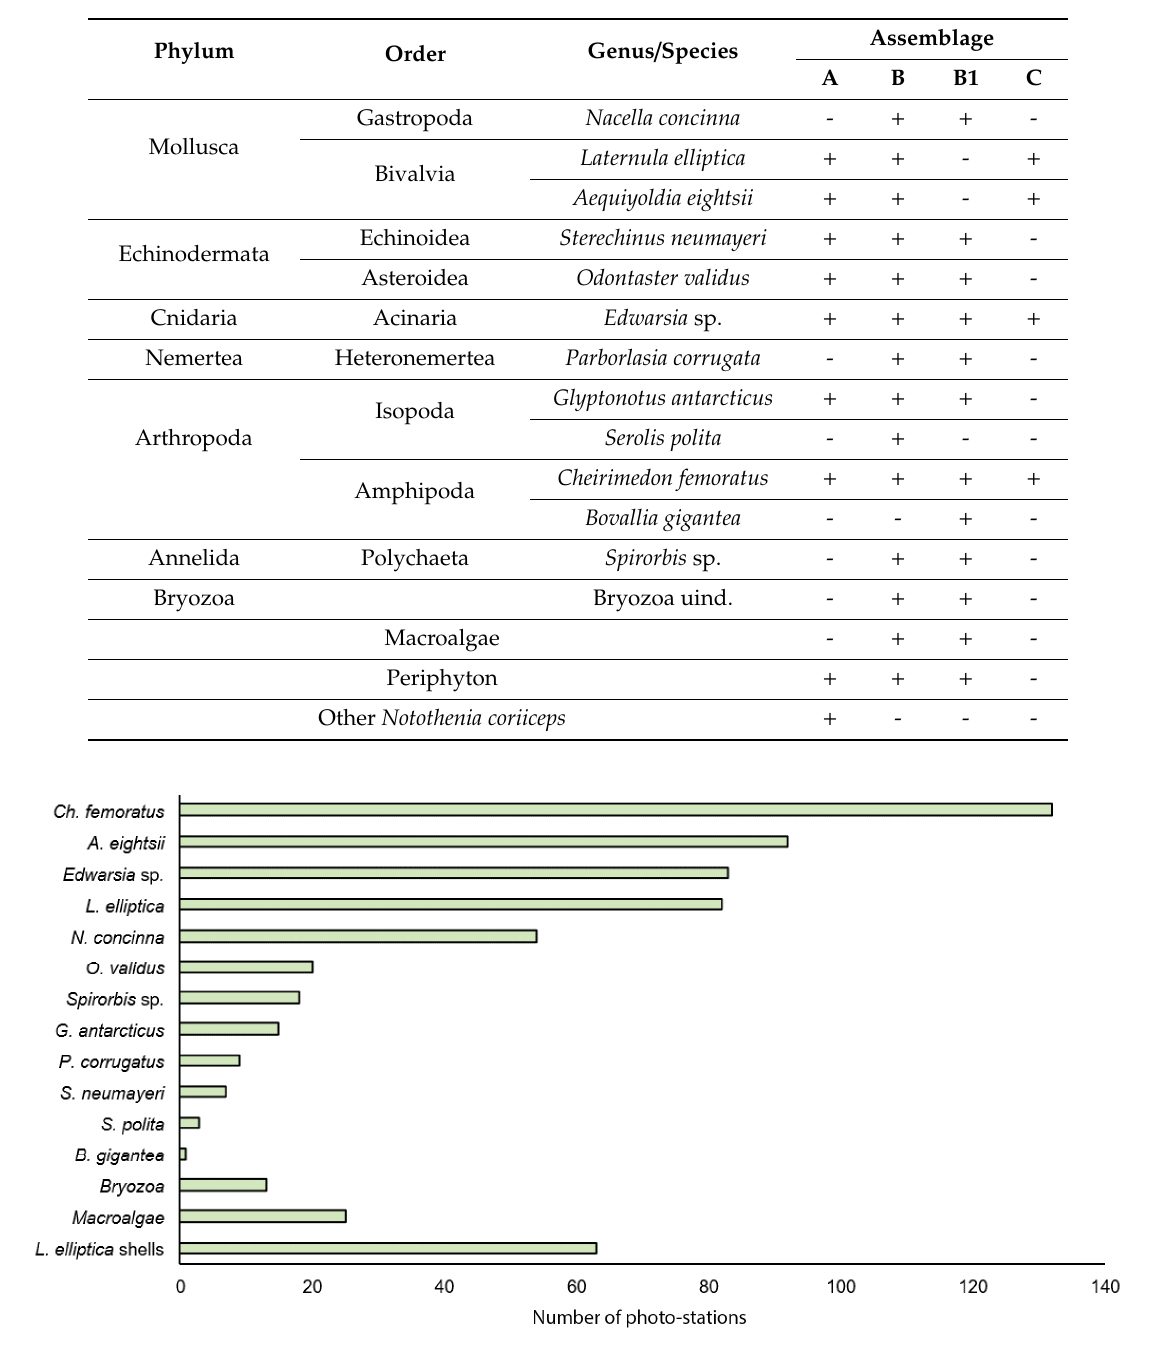
Figure 2. Benthic species occurrence at photo stations in Herve Cove.